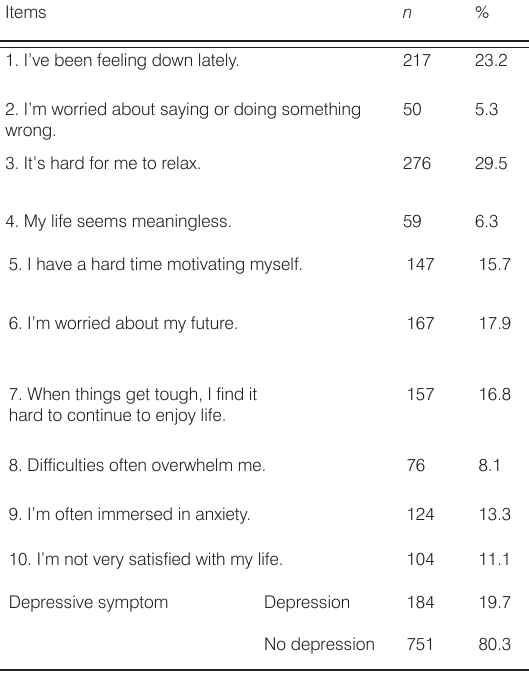
Table 2. ADL of participants ( N = 935).